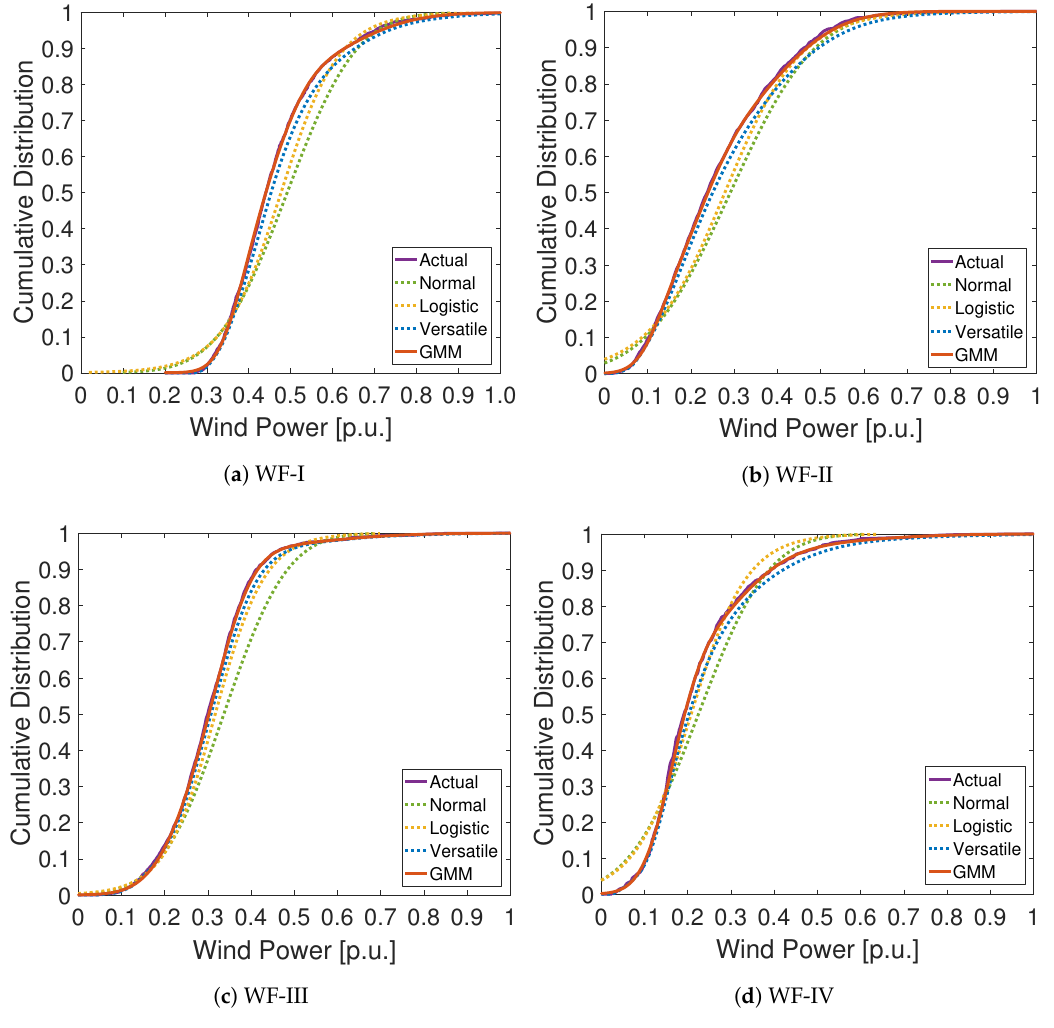
Figure 4. CDF comparisons of four wind farms; ( a ) WF-I; ( b ) WF-II; ( c ) WF-III; ( d ) WF-IV. Table 3. Metrics of four distributions estimated for the